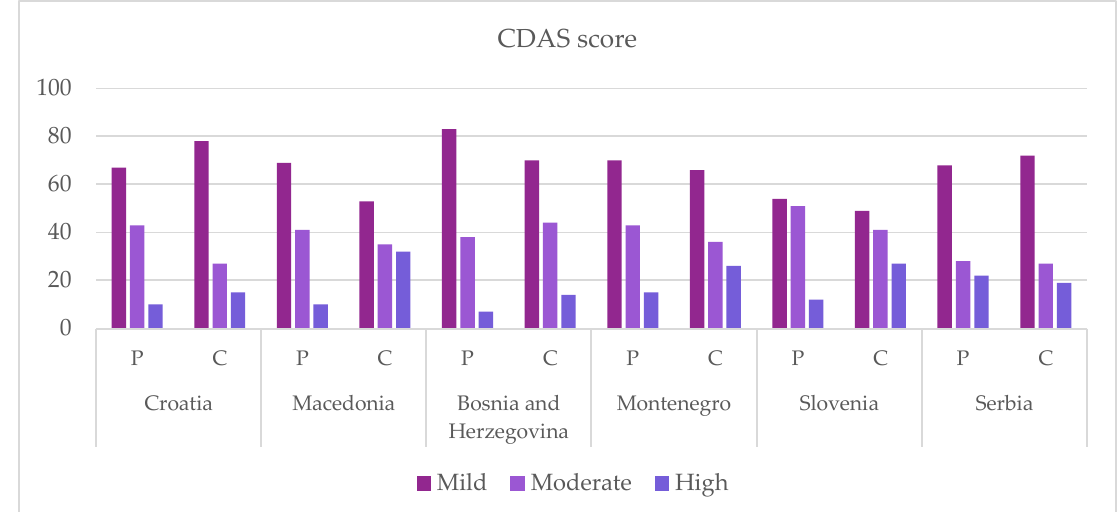
Figure 1. CDAS (Corah Dental Anxiety Scale) distribution: low (CDAS results 4–8), moderate (CDAS results 9–12) and high anxiety (CDAS results 13–20); P—parents; C—children.